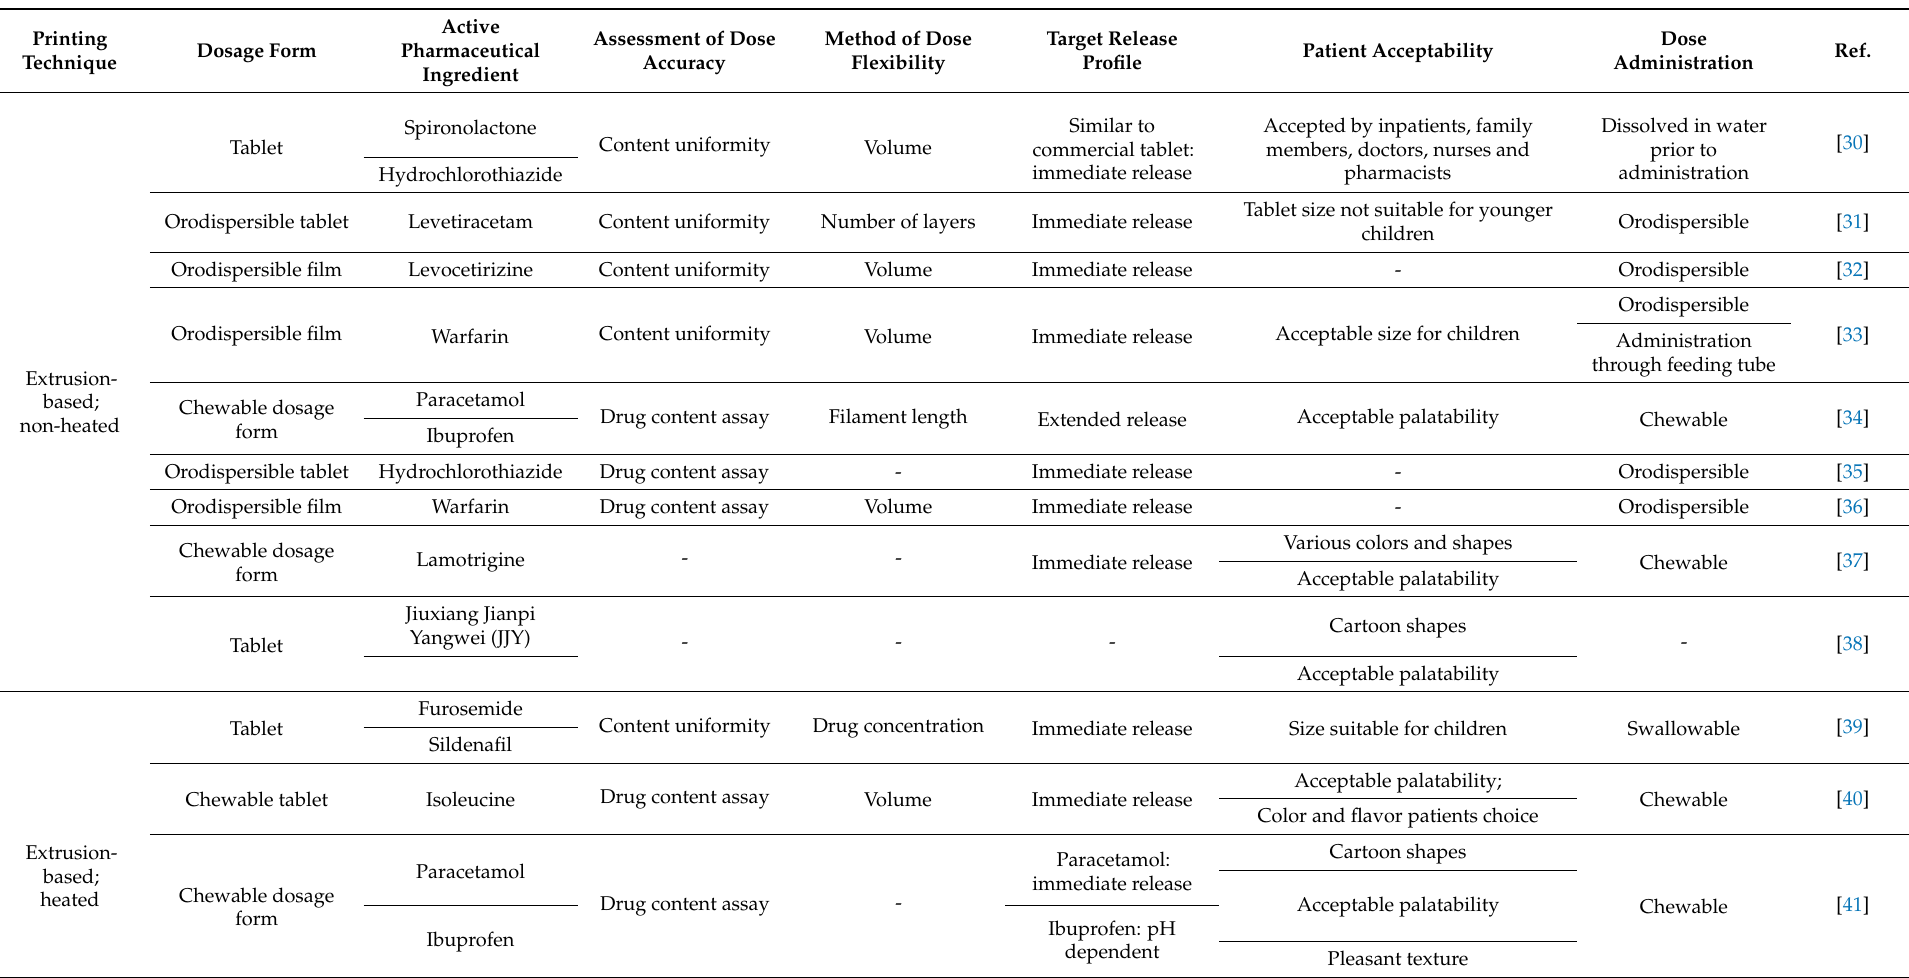
Table 1. Overview of the investigated key attributes of interest for 3D-printed oral dosage forms. Unknown or unpublished data are indicated by